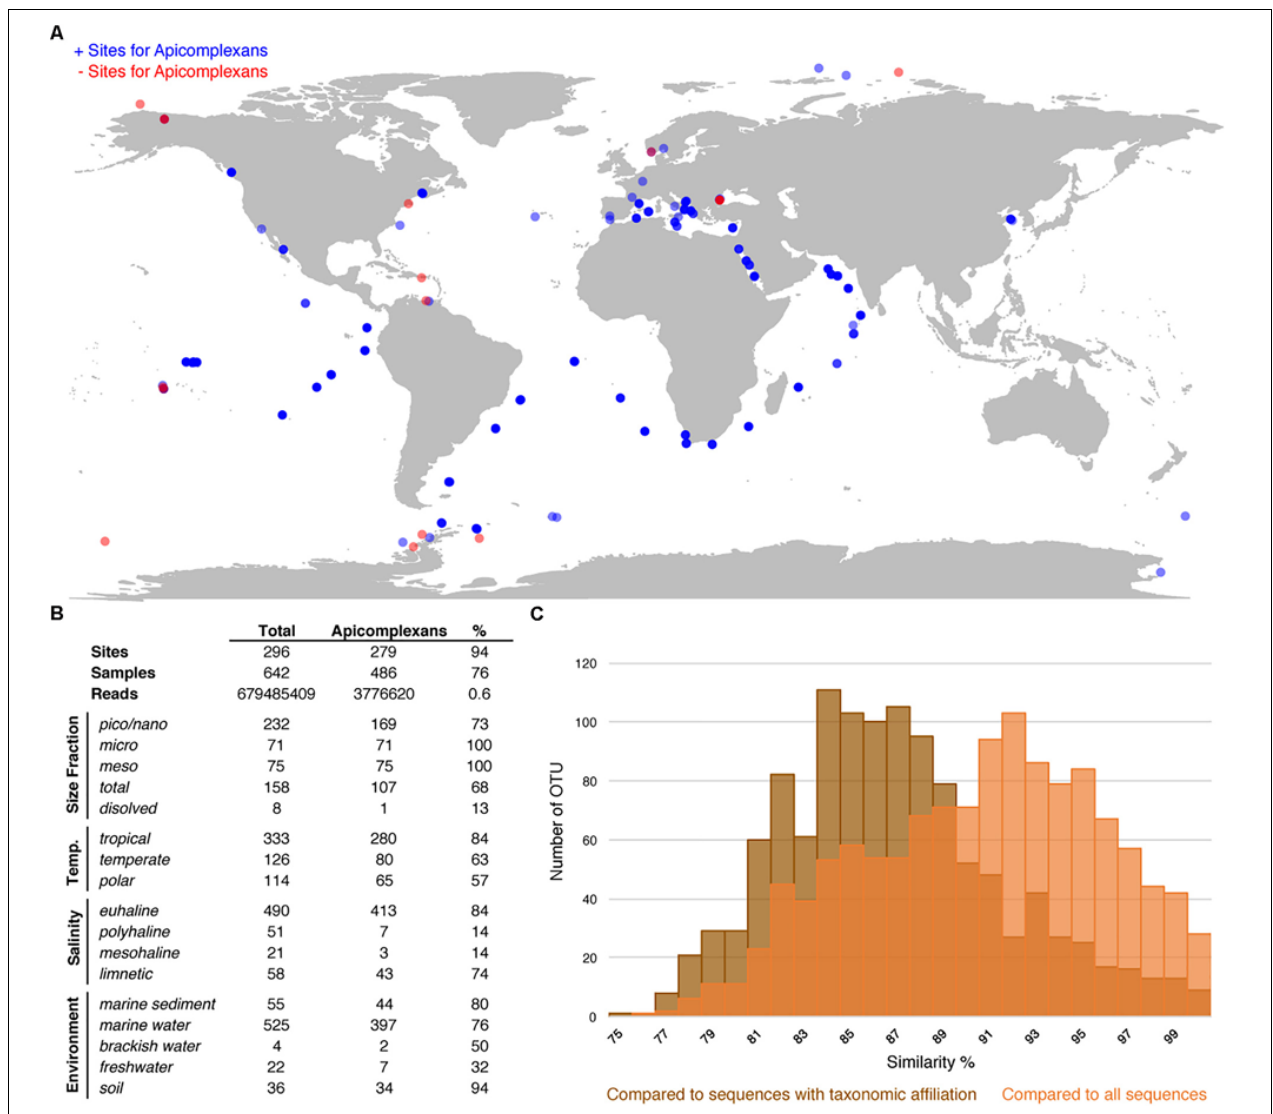
FIGURE 3 | (A) World map showing all the HTES analyzed sites, in blue the sites where apicomplexan reads have been reported in red those in which no apicomplexan reads have been found. (B) Distribution (presence) of apicomplexans in the analyzed HTES datasets as a whole and clustered by different features. Size fraction (pico/nano: 0.8–20 µ m, meso: 20–180 µ m, micro: 180–2000 µ m, total: no size fractioning, dissolved: dissolved DNA), temperature (tropical: > 18 ◦ C, temperate: 10–18 ◦ C, polar: < 10 ◦ C), salinity (euhaline: 30–40 PSU, polyhaline: 18–30 PSU, mesohaline: 5–18 PSU, limnetic: < 0.5 PSU). (C) Blast similarity against GenBank of the HTES apicomplexan reads. In brown the results when comparing against sequences annotated with taxonomic affiliation and in orange the results when comparing against all the apicomplexan sequences including those environmental sequences that do not correspond to any identified apicomplexan